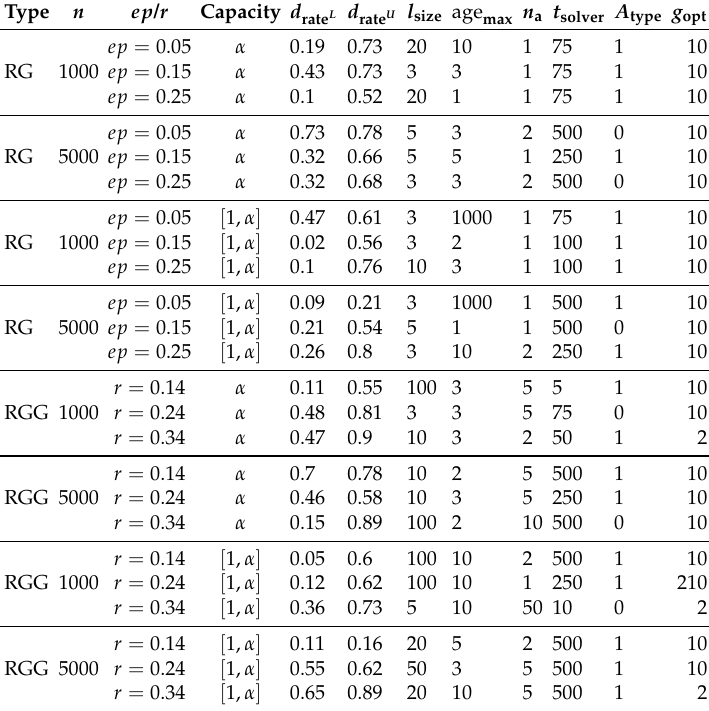
Table 3. C MSA ++ parameter values generated by irace for the new data set of large problem instances.